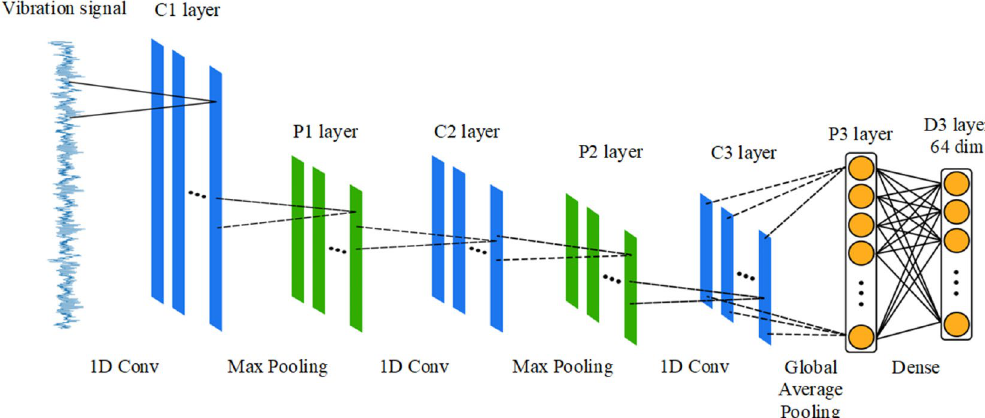
Figure 3. Hierarchical framework of 1DCNN.